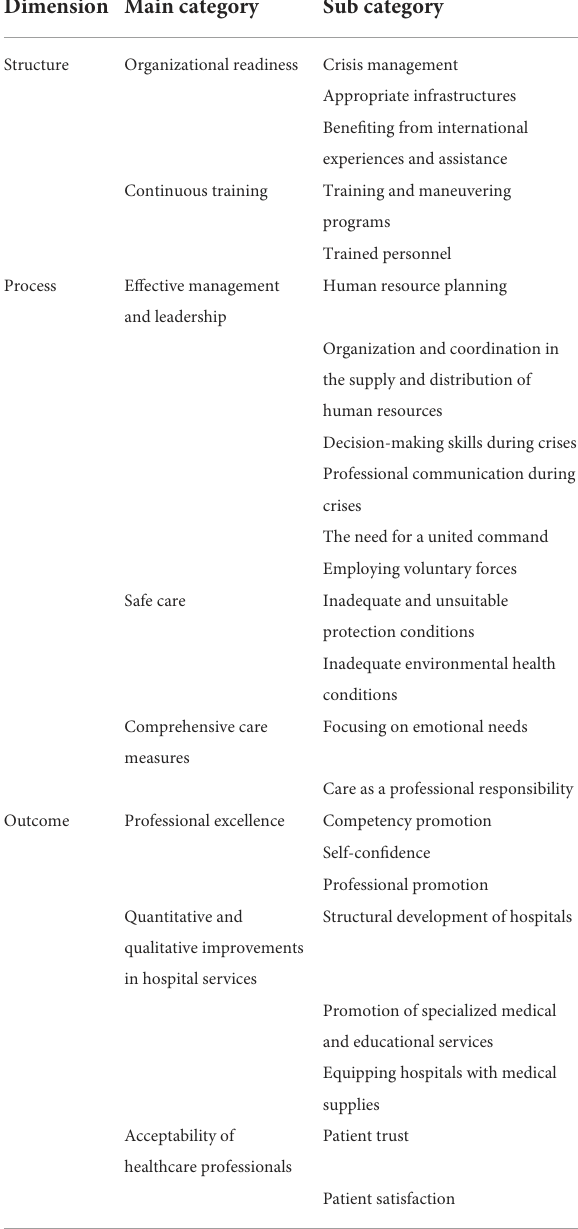
TABLE 2 Main categories, generic categories, and subcategories obtained from the direct content analysis. Dimension Main